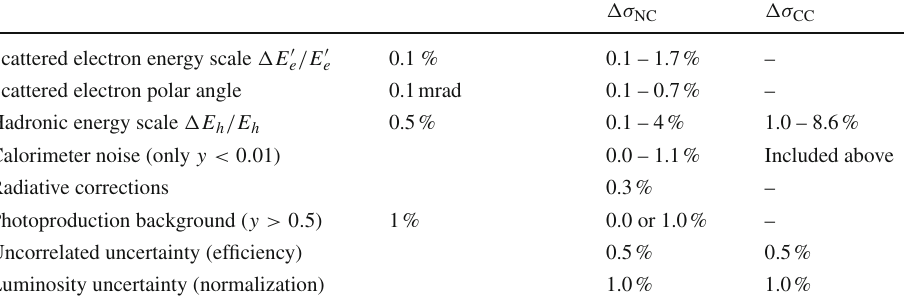
Source of uncertainty Size of